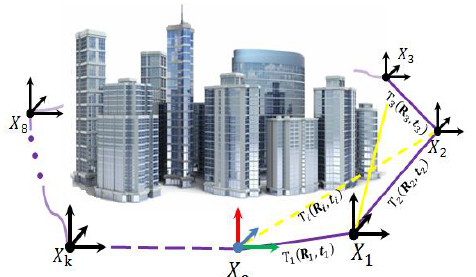
Figure 3. Pairs of point clouds before pairwise and global refinement.